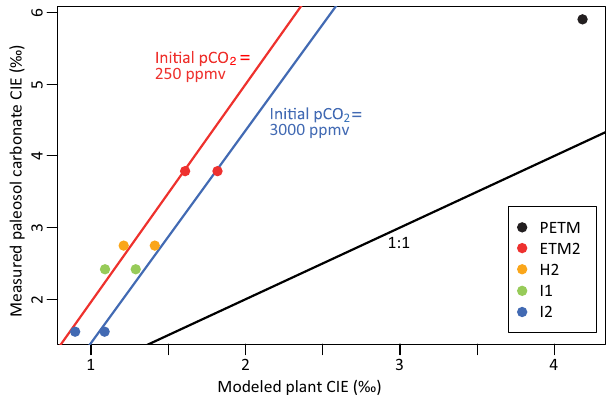
Figure 5. Carbon isotope excursions (CIEs) for the PETM, ETM2, H2, I1, and I2 events in the early Eocene compared between pa- leosol carbonate ( y axis) CIEs in the Bighorn Basin, Wyoming (USA), and measured and modeled plant CIE for two extreme initial p CO 2 scenarios. The plant CIE for the PETM is measured (Smith et al., 2007); those of the younger four hyperthermals are modeled (see text for explanation). Note that the trend lines for both extreme p CO 2 scenarios do not fit the measured CIEs in plant and pedogenic carbonate for the PETM.